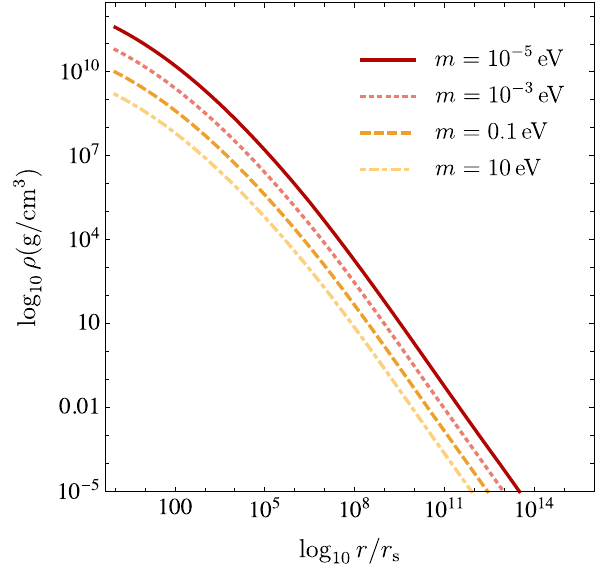
Fig. 1 Halo-profile density ρ (in units of g / cm 3 ) around a PBH as a function of r / r s , assuming the formation mechanism discussed in Refs. [33,34]. The values of the particle mass m for each curve are m = 10 − 5 eV (maroon solid curve), m = 10 − 3 eV (pink dotted curve), m = 0 . 1eV (orange dashed curve), and m = 10eV (yellow dot-dashed curve),